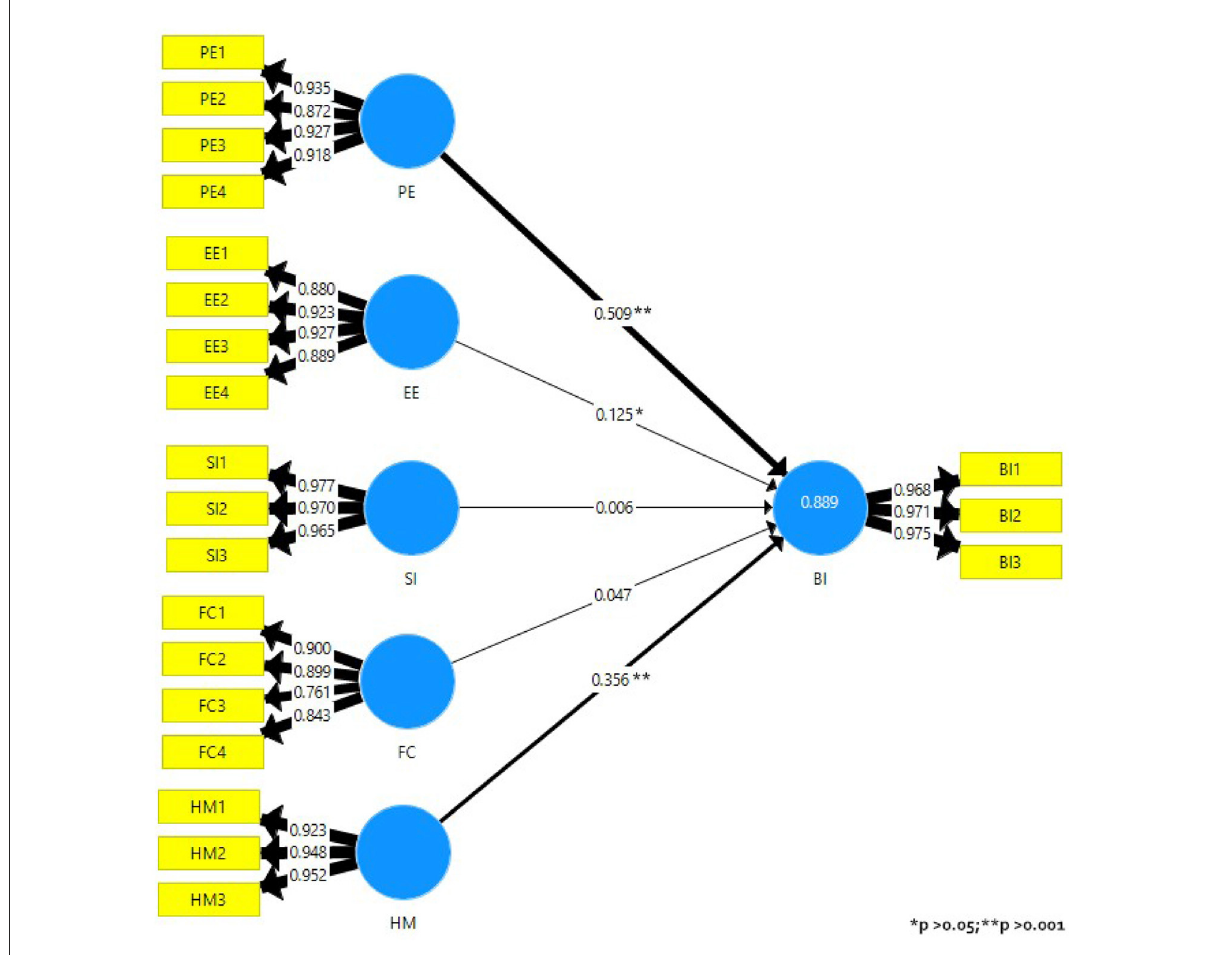
FIGURE2 Results of the structural